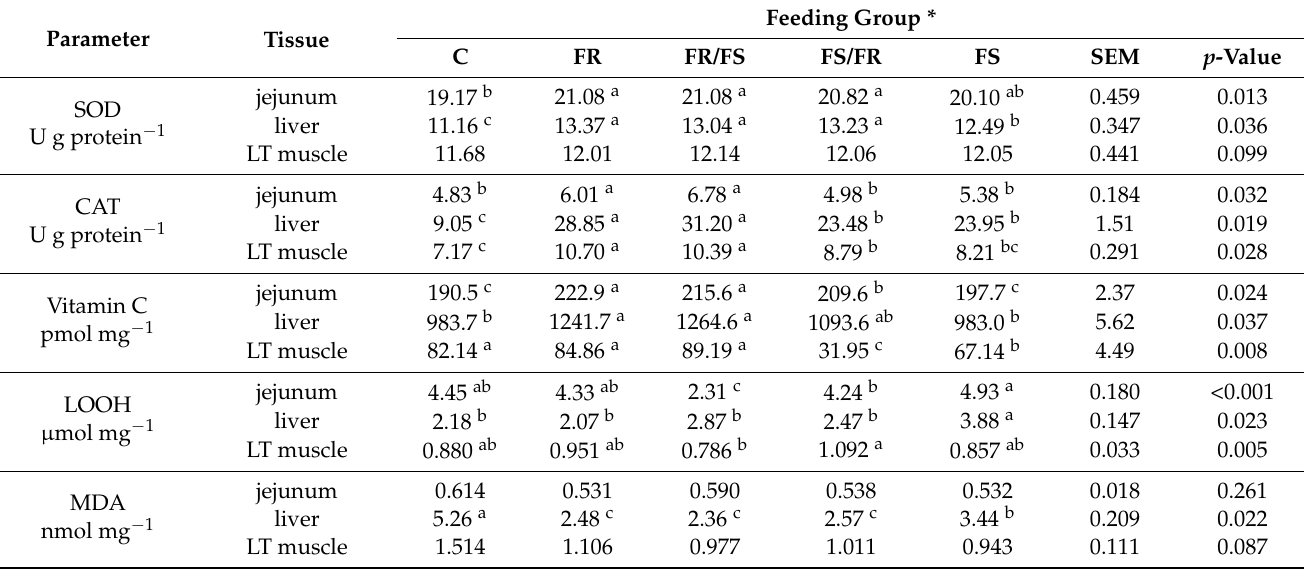
Table 5. Effect of fermented components on redox status parameters of selected tissues of